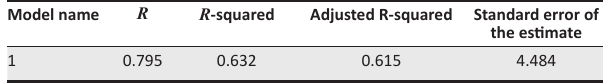
TABLE 4a: Regression analysis results: Model